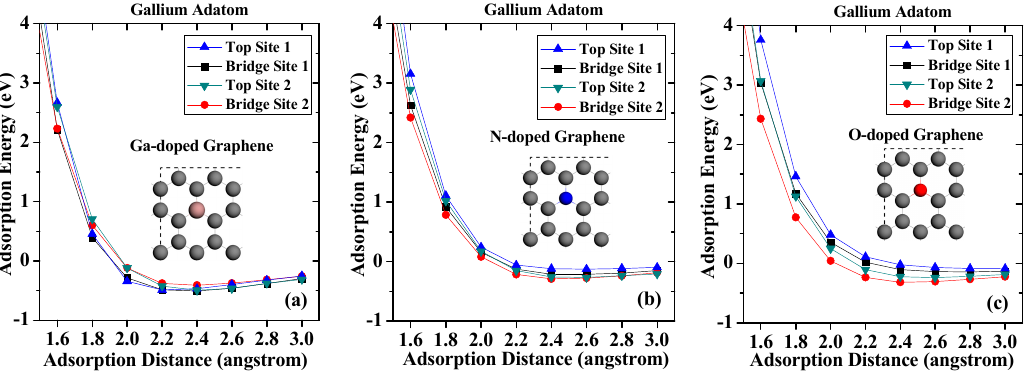
Figure 3. Adsorption energies of gallium on ( a ) Ga-doped graphene; ( b ) N-doped graphene; ( c ) O-doped graphene.